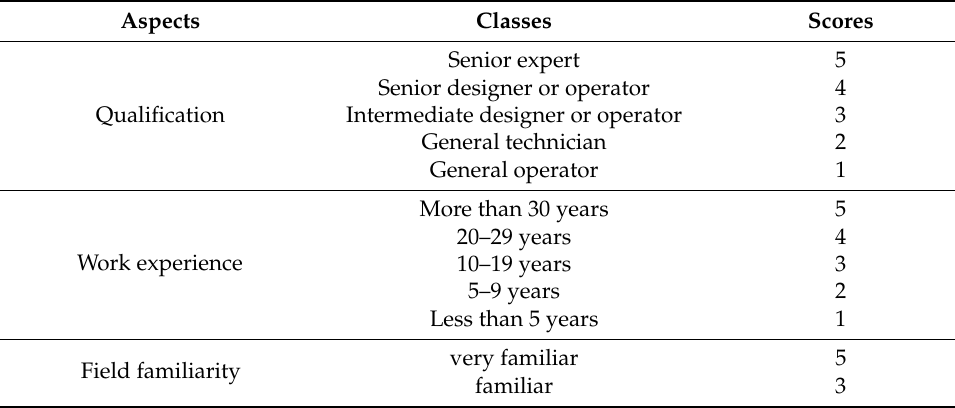
Table 1. Weight allocation table of expert